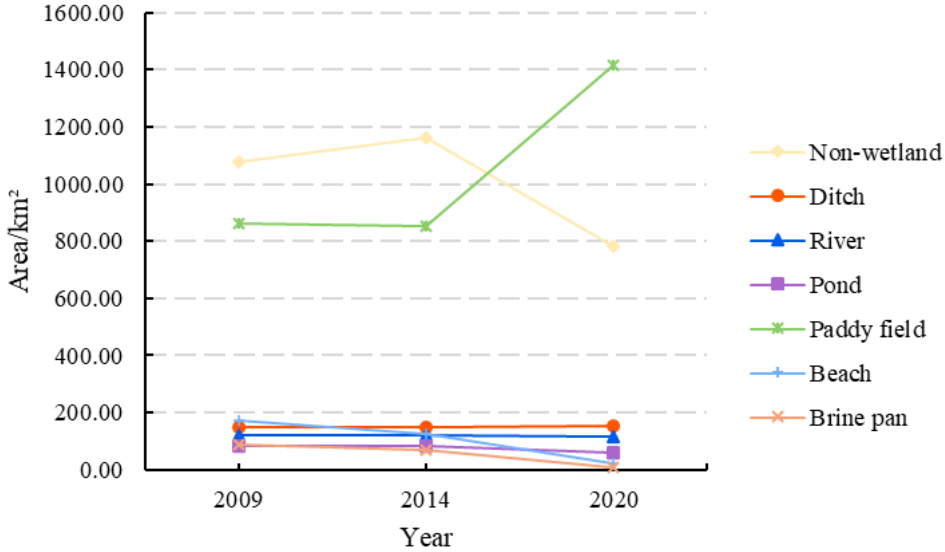
Figure 4. Changes in the area of different landscape types in the study area during 2009–2020. Table 5. The dynamic rate of different landscape types in the study area during 2009–2020. Landscape Types